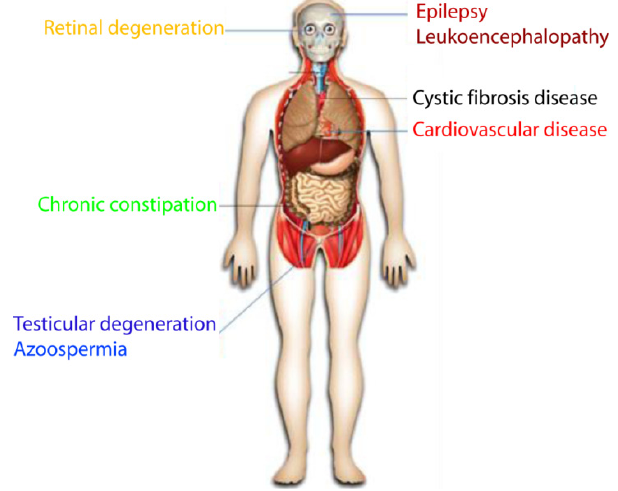
Figure 3. ClC-2 chloride channelopathies. Schematic illustration of human diseases that can be caused by loss of ClC-2